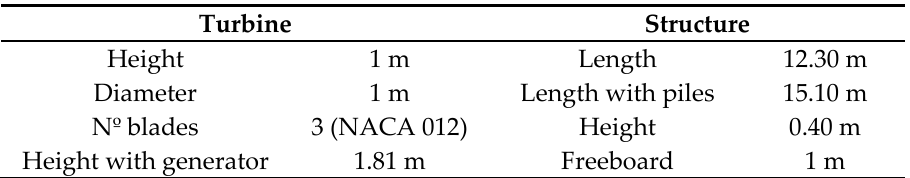
Table 1. Main dimensions of the